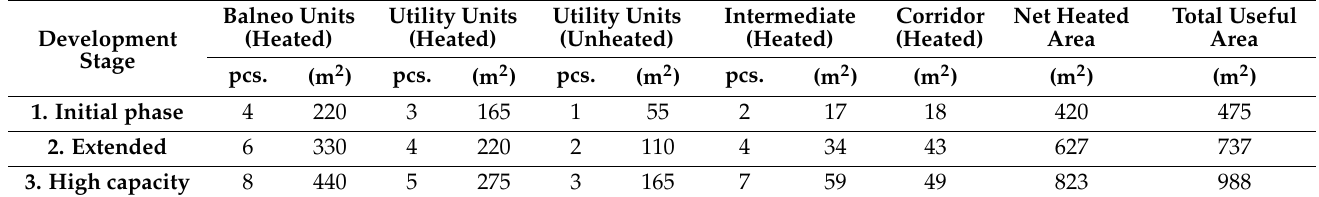
Table 2. Development stages—an overview of basic